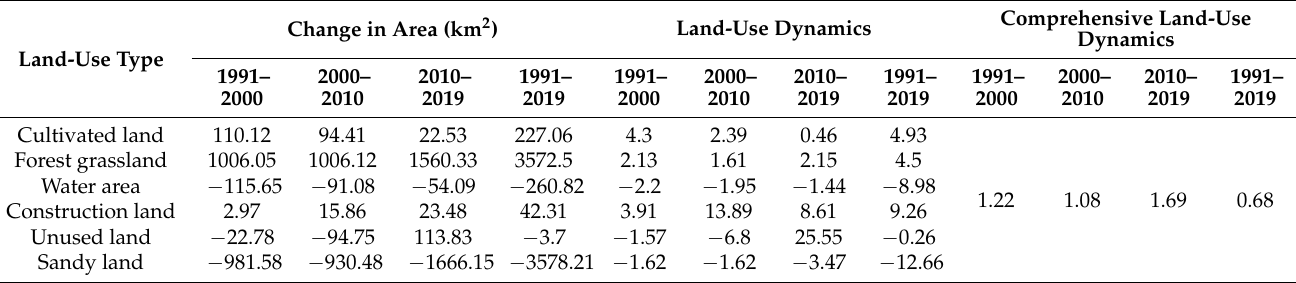
Table 5. The land-use dynamics in various periods along the Yellow River section of the Hobq